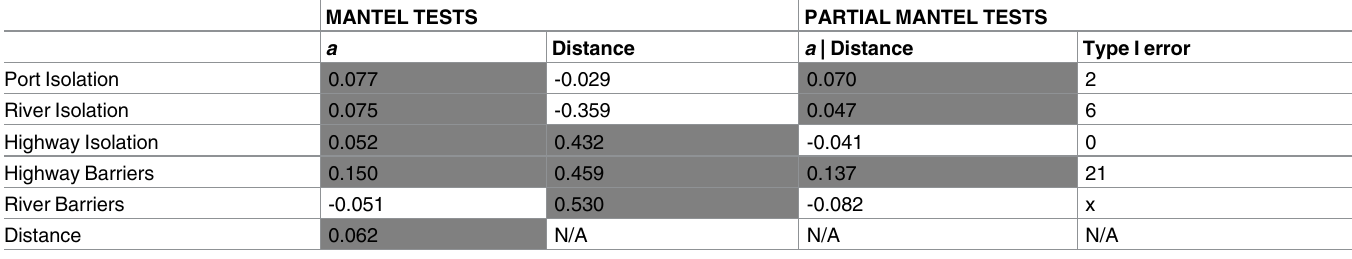
Table 1. Results of Mantel and partial Mantel tests. Cells containr scores and shaded cells indicate statistical significanceat P < 0.001. Mantel tests are betweenlandscapevariables(including geographicdistance)and Rousset’s a , and betweenlandscapevariablesand geographic distance. Partial Mantel tests are betweenlandscapevariablesand Rousset’s a , after accountingfor geographicdistance. The numberof Type I error simulations (out of 100) showing significanceis indicatedfor each partial Mantel